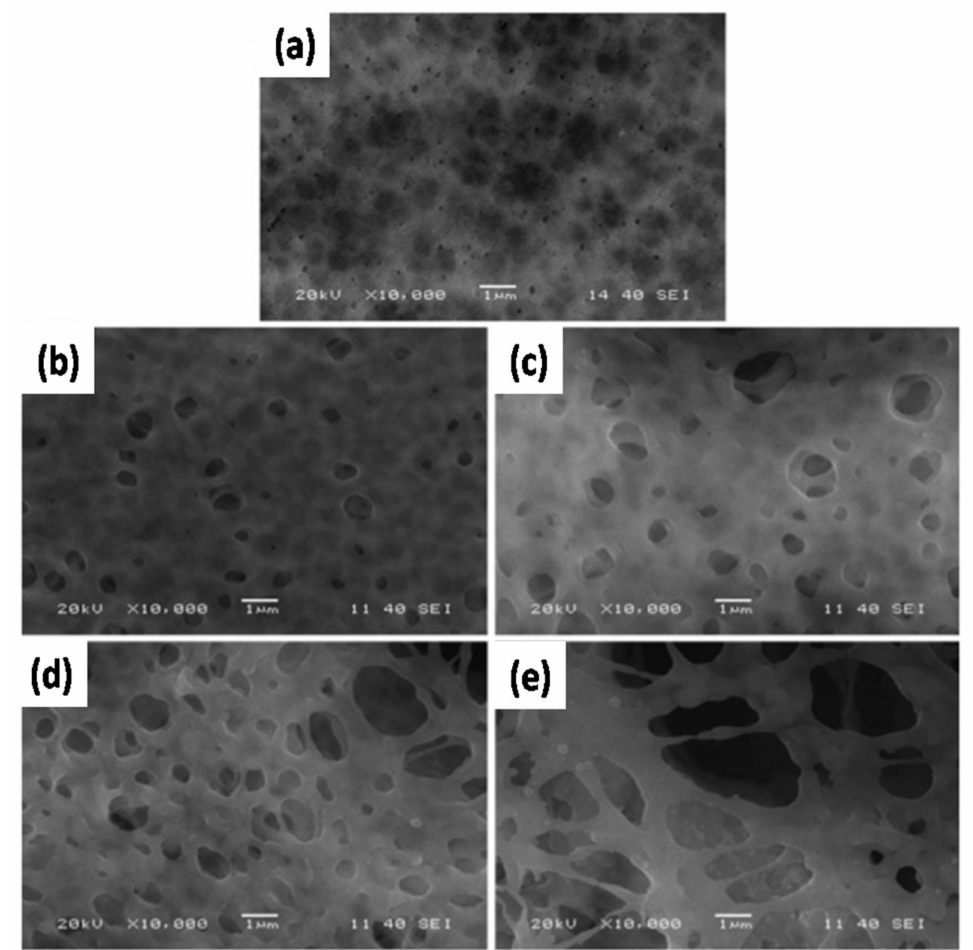
Figure 14. SEM images of the GPE membrane: ( a ) pristine PVDF, ( b ) PVDF-1% SiO 2 (Li + ), ( c ) PVDF-2% SiO 2 (Li + ), ( d ) PVDF-5% SiO 2 (Li + ), and ( e ) PVDF-10% SiO 2 (Li + ). Reprinted with permission from Li et al. [109]. Copyright 2013 Springer